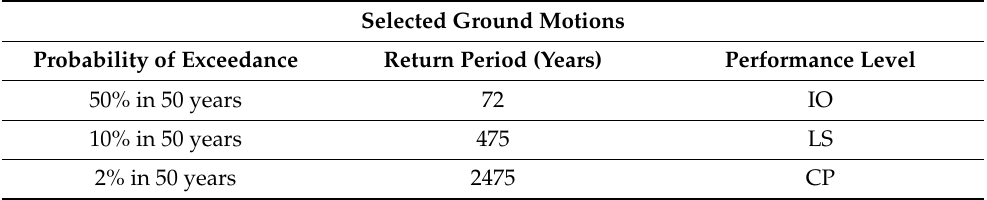
Table 3. Selection of ground motions based on performance